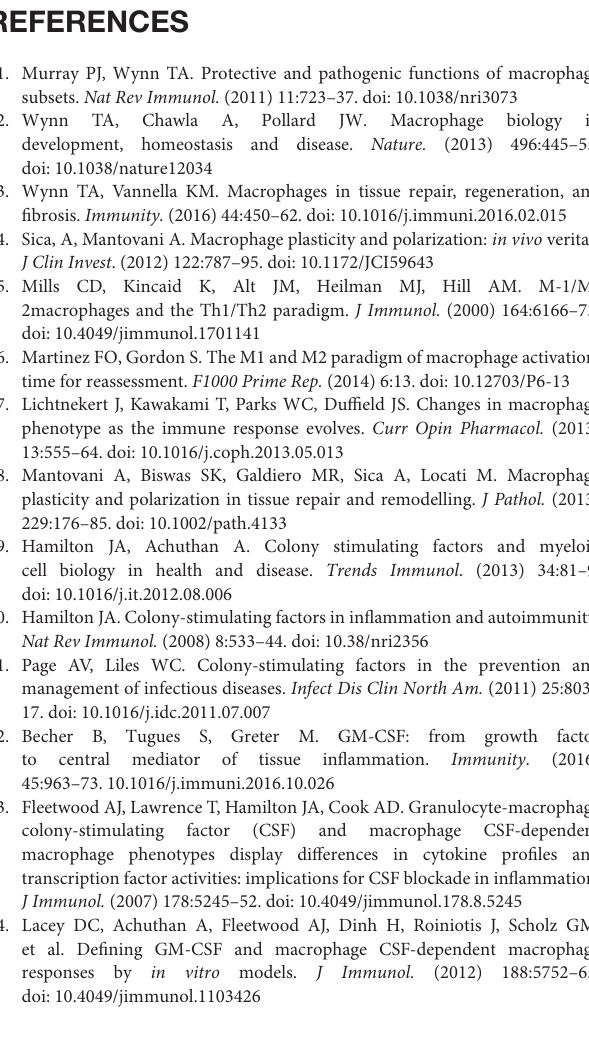
triplicate experiments. The statistical analysis was performed by two-way ANOVA and Turkey’s multiple comparisons test in Prism 7. In (A,B) , P < 0.05 is indicated by ∗ for comparison of the indicated groups. In (C) , P < 0.05 is indicated by ∗ for comparison of stress vs. DMSO in M-BMDMs, by # for comparison of stress vs. DMSO in GM-BMDMs, by ※ for comparison of M DMSO vs. GM DMSO and by 9 for comparison of M-BMDM stress vs. GM-BMDM DMSO. Figure S2 | Cellular stress and TLR induced apoptosis in BMDMs. M-BMDM and GM-BMDM were treated with DMSO or Tm (1 mg/ml) for 6h prior to stimulation with LPS (100ng/ml) for 10h. (A) Cells were stained for Annexin and analyzed by flow cytometry. The percentage of annexin V positive cells (B) and the mean fluorescence intensity (C) for each treatment group were quantified. (D) The cells were also stained with PI (red) and Hochest (blue). (E) Levels of cleaved caspase 3 protein from these cells were analyzed by Western blot. Data are presented as the mean ± SD of triplicate experiments and the differences between indicated